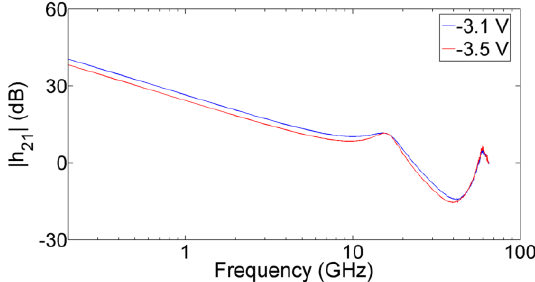
Figure 9. Measured h 21 from 0.2 to 65 GHz for a GaN HEMT at V DS = 30 V and V GS = −3 .1 V under four ambient temperatures: 35 °C, 90 °C, 145 °C, and 200 °C.